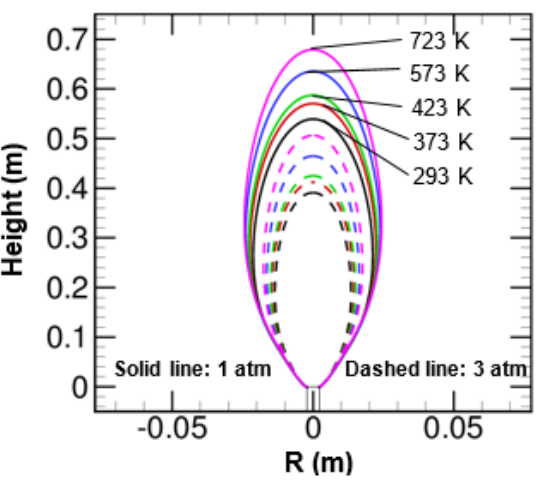
Figure 18. Effect of air temperature on the stoichiometric mixture fraction surface at 1 and 3 atm.